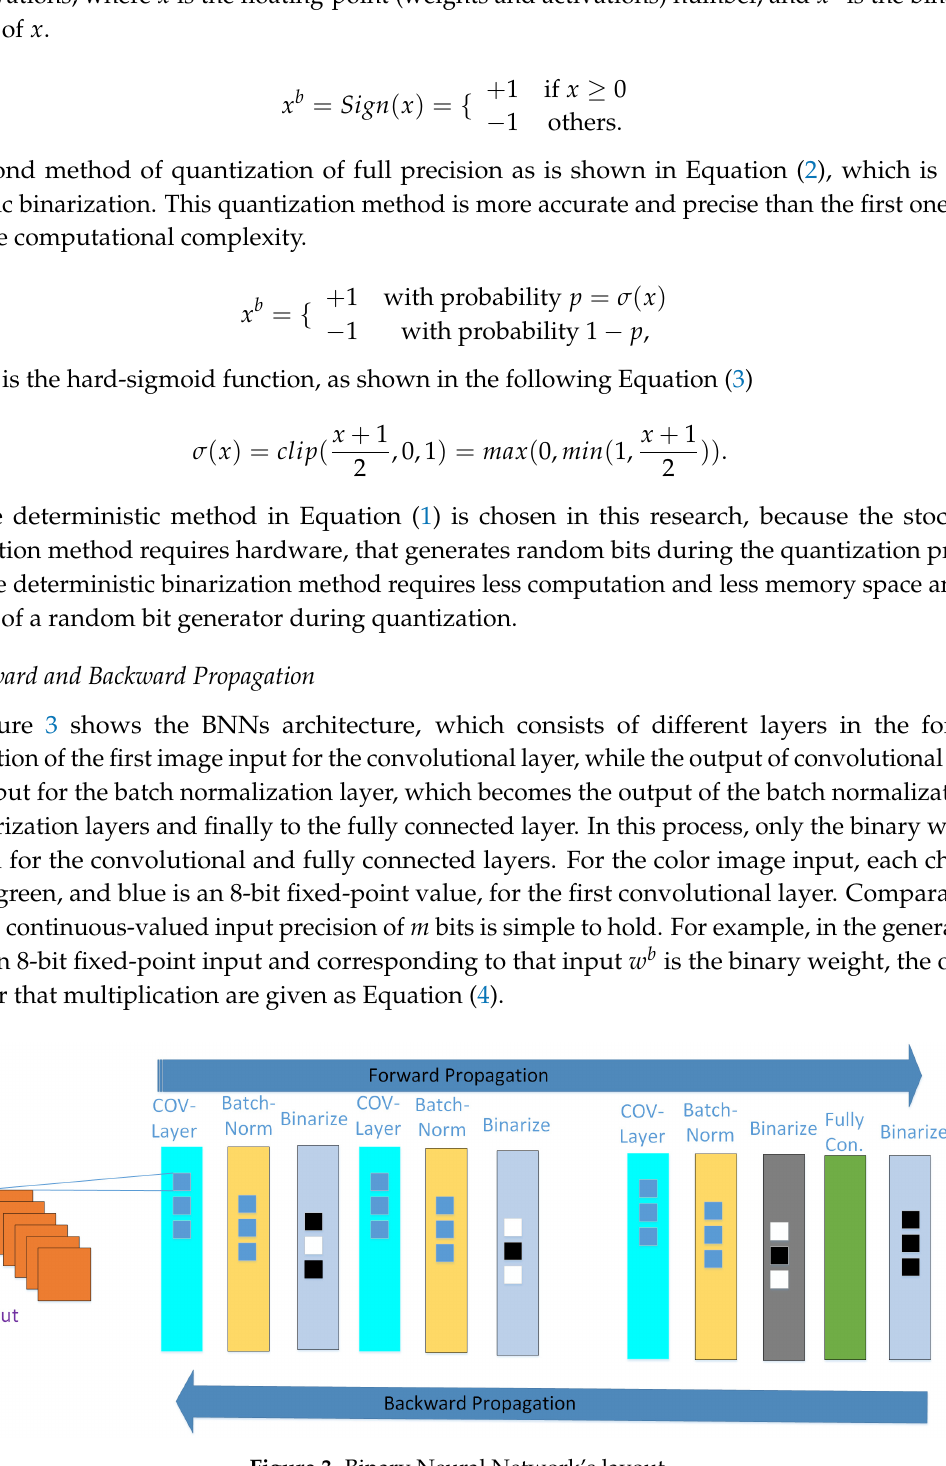
Figure 3. Binary Neural Network’s